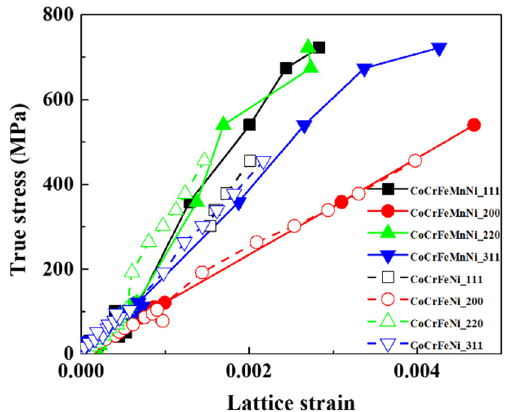
Figure 2. Lattice strain evolution with respect to true stress along the axial loading direction in the CoCrFeNi and CoCrFeMnNi